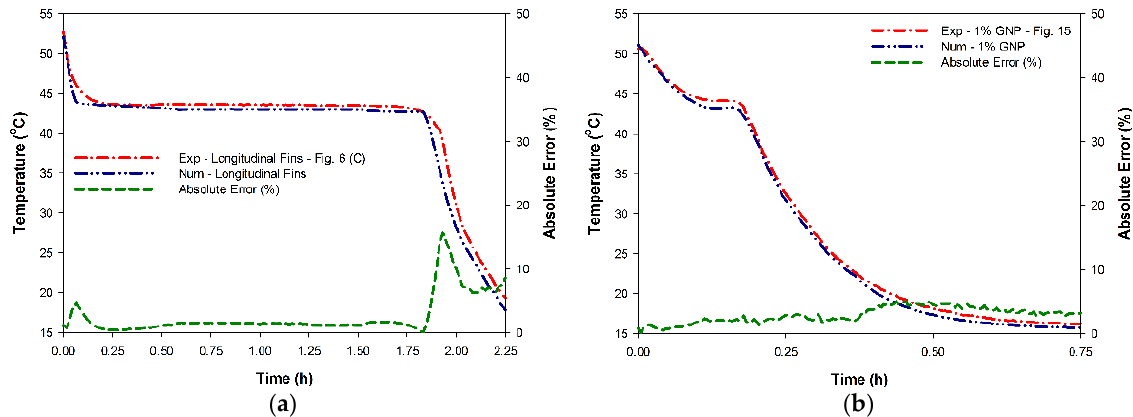
Figure 1. Validation of the numerical model with experimental temperature profiles: ( a ) paraffin with longitudinal fins and ( b ) nano-PCM with 1% GNP in shell-and-tube configurations.